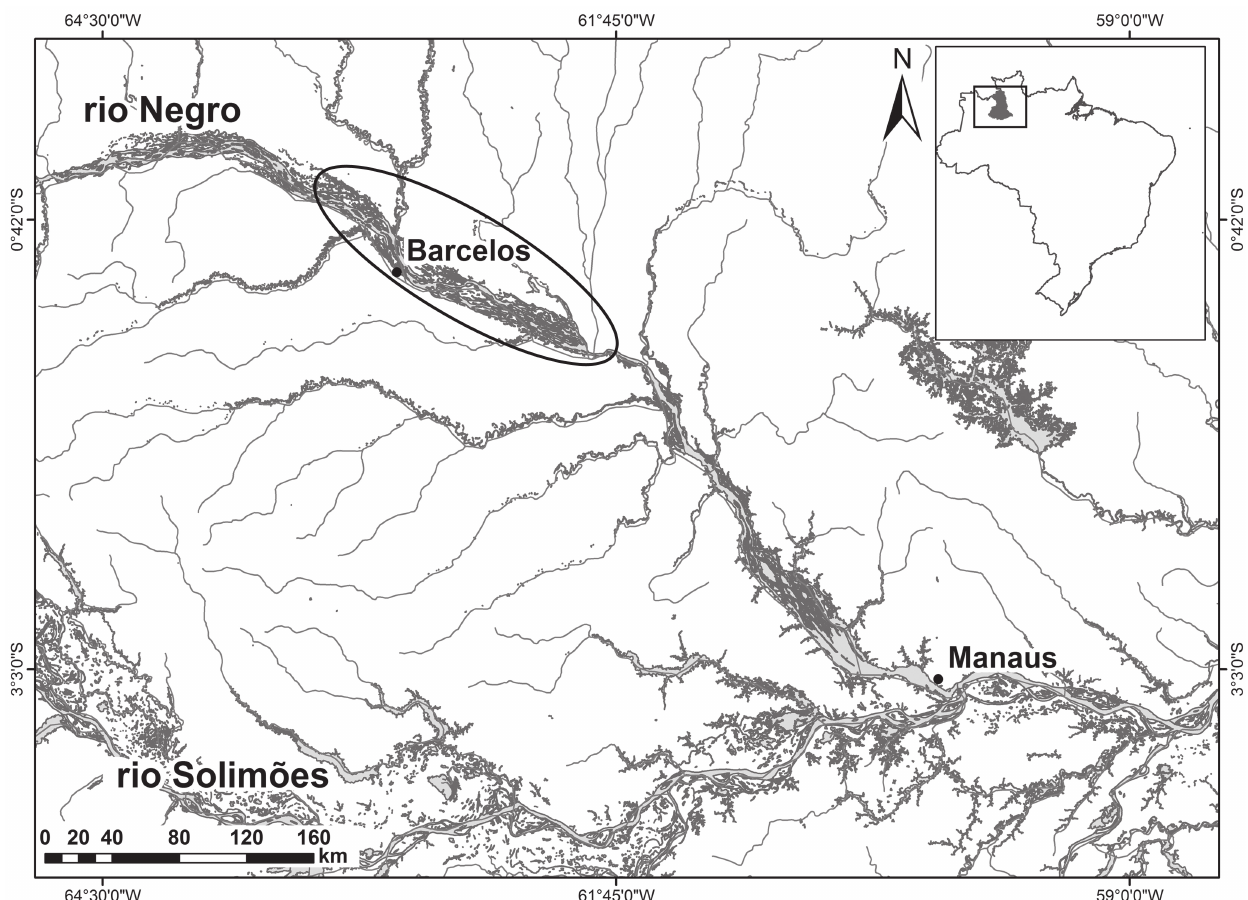
Fig. 1. Middle and lower stretch of the rio Negro (Amazonas, Brazilian Amazonia), with sampling area of Cichla temensis near the Barcelos municipality highlighted by a